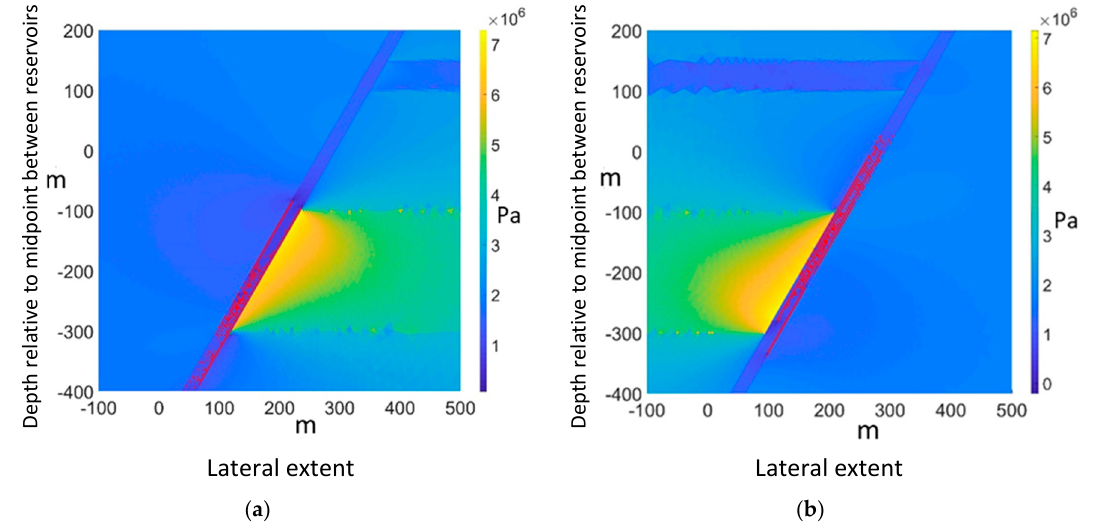
Figure 5. ( a ) For reservoirs in the hanging wall, shear fractures appear in the fault’s process zone as depletion reaches 5 MPa (10 MPa pore pressure). The failed elements are shown in red; ( b ) For reservoirs in the footwall, the picture is reversed (10 MPa pore pressure). Effective horizontal stress is plotted, scale in Pa.